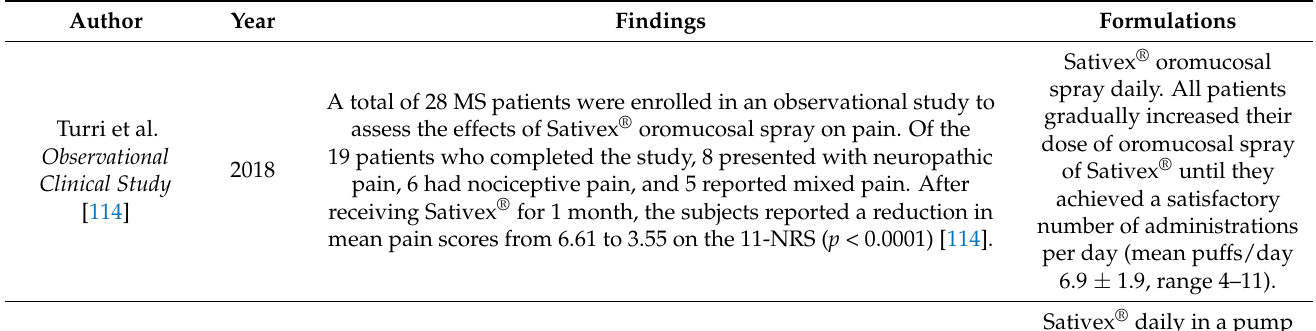
Table 2. Effects of cannabinoids on pain intensity in multiple sclerosis.